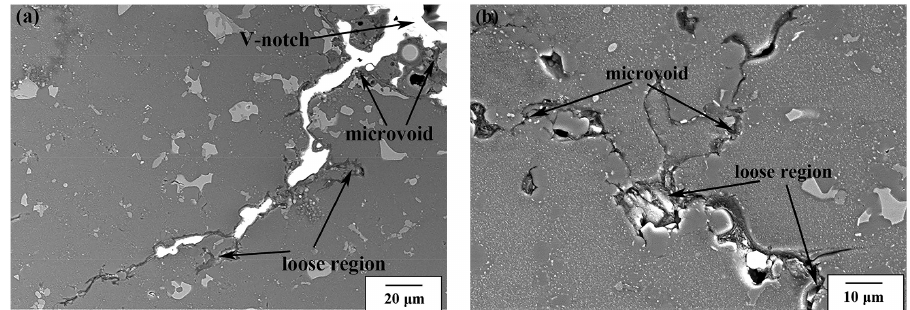
Figure 11: Cracks initiating at the microvoids and loose